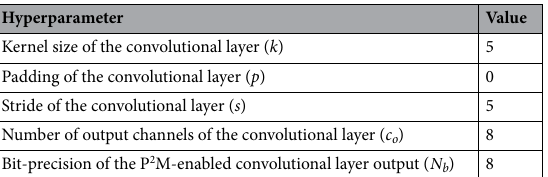
Table 1. Model hyperparameters and their values to enable bandwidth reduction in the in-pixel layer.